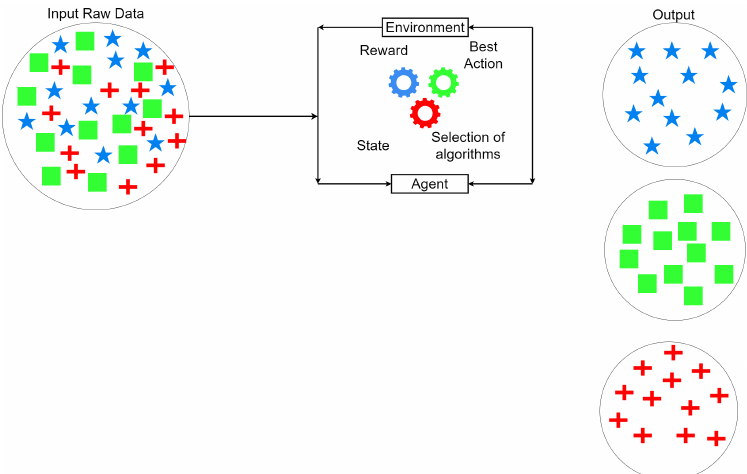
Figure 3. Example of reinforcement